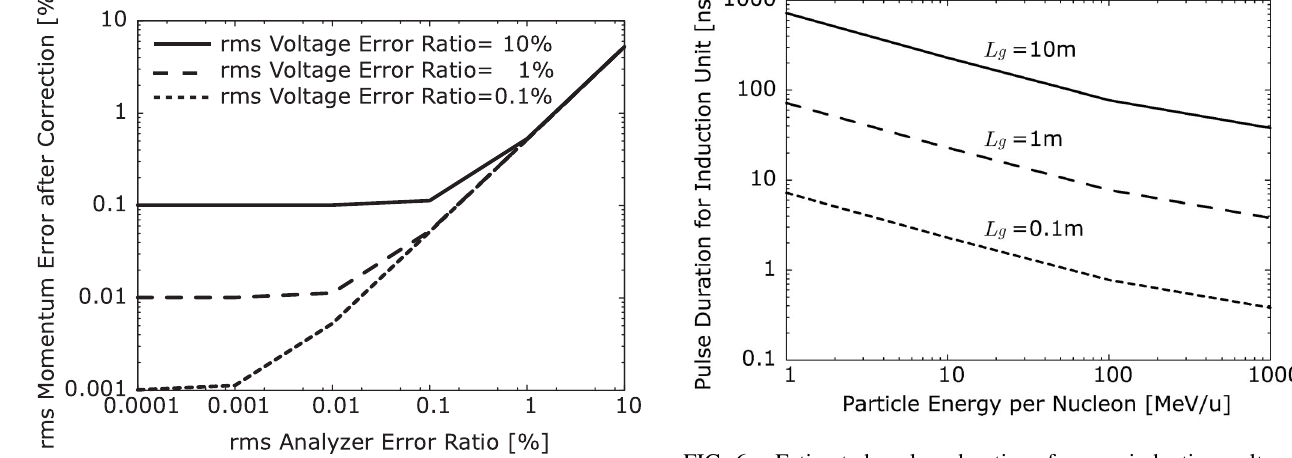
FIG. 6. Estimated pulse duration for an induction-voltage modulator as a function of particle energy per nucleon. FIG. 5. Corrected momentum error as a function of detection errors at an analyzer and voltage fluctuations of an induction modulator. The particle energy per nucleon is assumed as 100 MeV = u . The initial momentum error is (cid:1) 1% . The normal- =A is 1.9 MV as shown in Fig. ized voltage required qV ind